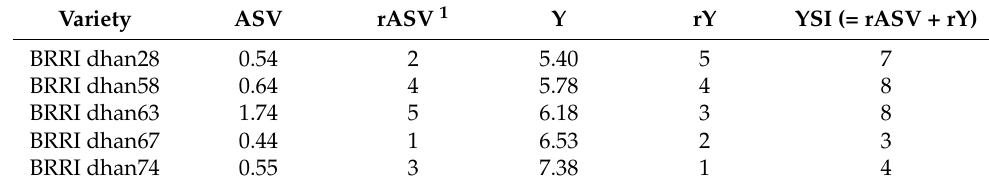
Table 4. AMMI stability value (ASV) and yield stability index (YSI) of the rice varieties.